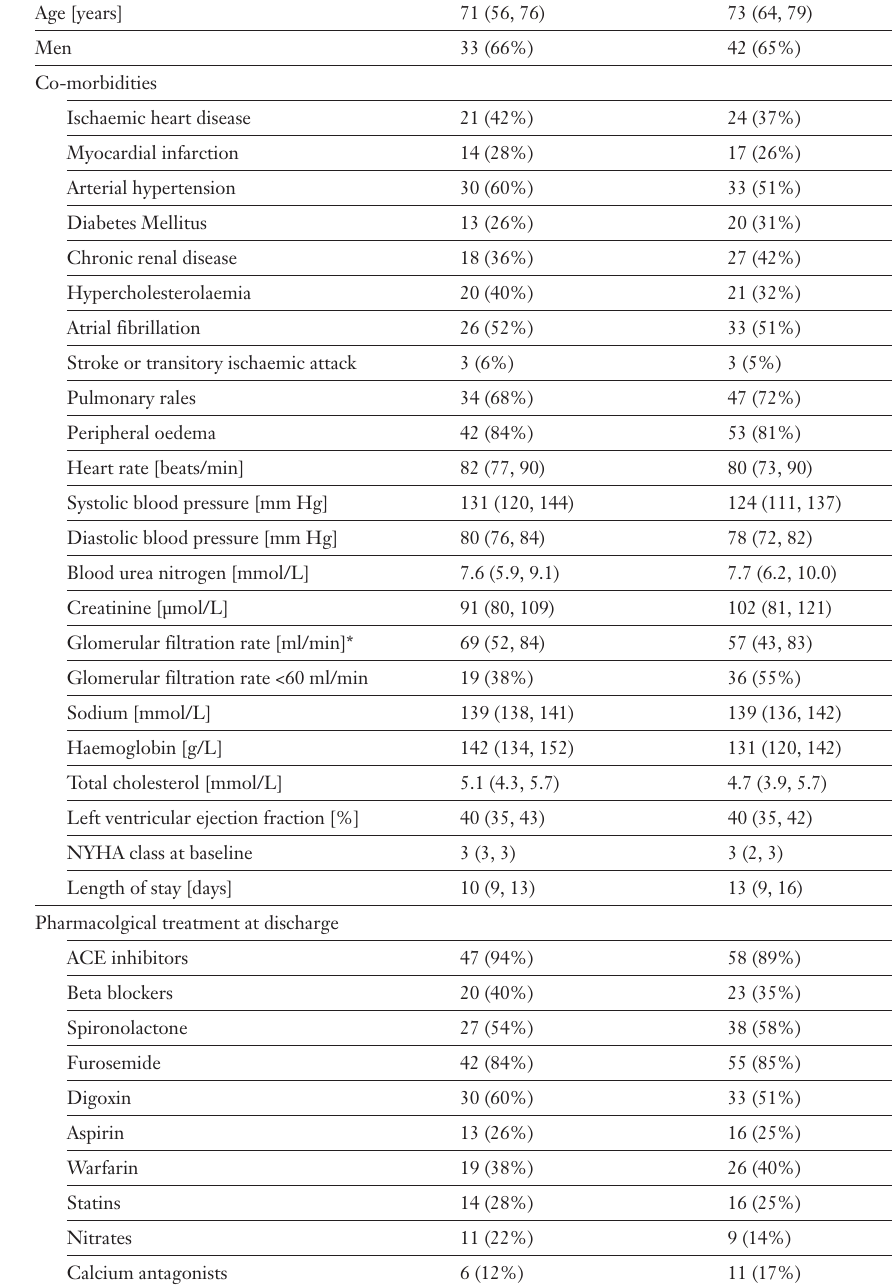
Table 1 Baseline demo- graphic and clinical characteristics. Values are median (25 th , 75 th percentile) or number (%) of